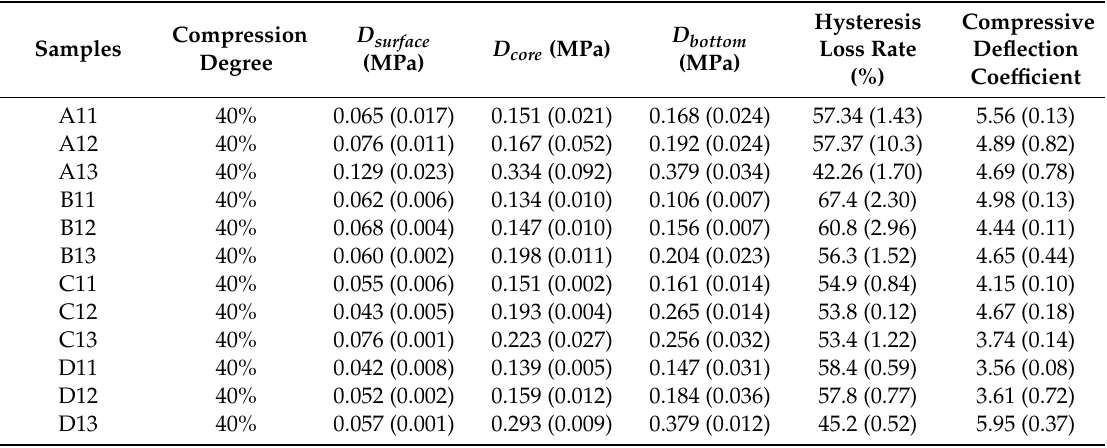
Table 3. The mechanical properties of mattresses of untreated and treated columned lu ff a which were hot-pressed to smooth plateau